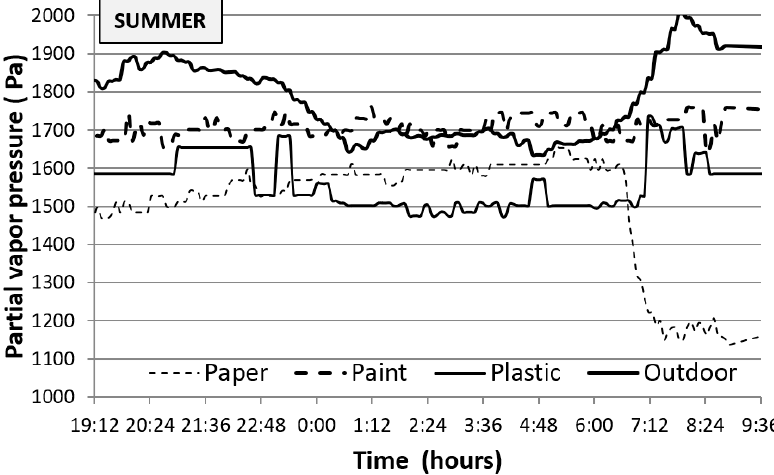
Figure 8. Indoor air enthalpy predicted for each internal covering during the winter season.